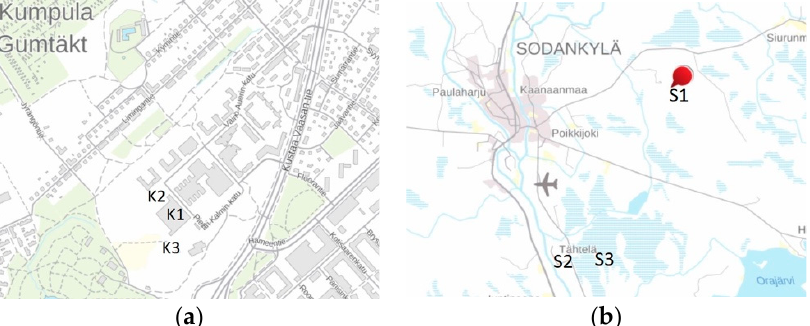
Figure 1. ( a ) The sampling sites at Kumpula (K1 is the roof of the Finnish Meteorological Institute FMI; K2 is the fenced land area of FMI; K3 is Station for Measuring Ecosystem-Atmosphere Relations SMEARIII). ( b ) The sampling sites at Sodankylä (S1 is Kommattivaara; S2 is the Nordkalotten Satellite